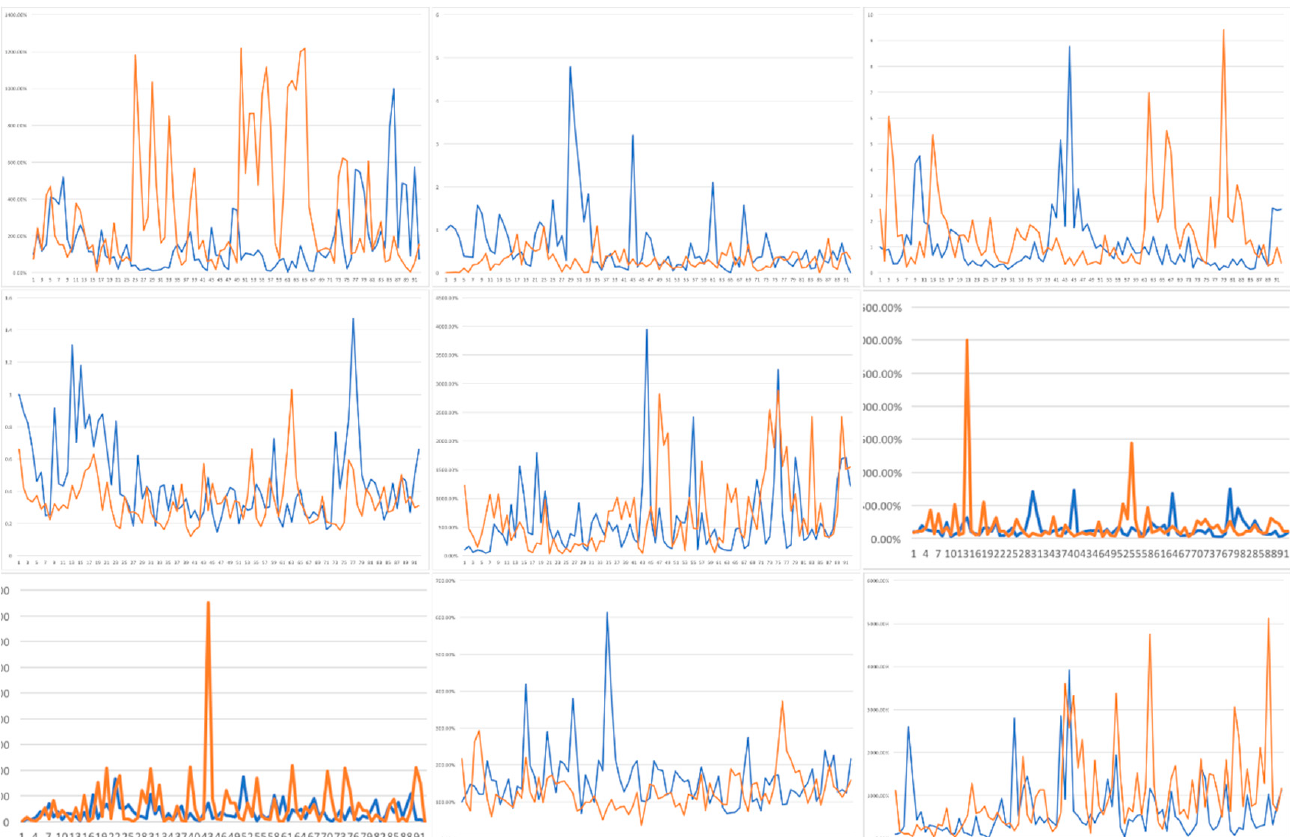
Figure 14. The daily trading volume 90 days before and after the split. The blue line represents the daily trading volume during the 90 days before the split and the yellow line the daily trading volume during the 90 days after the split.